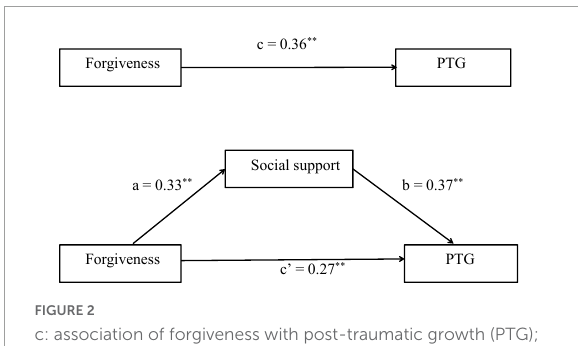
FIGURE2 c: association of forgiveness with post-traumatic growth (PTG); a: association of forgiveness with social support; b: association between social support and PTG; c’: association of